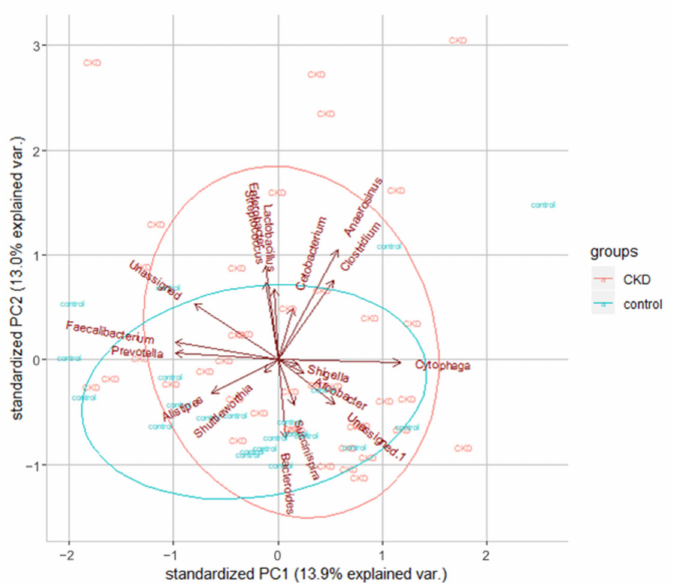
Figure 4. Dimension reduction analysis reveals the overall bacterial compositions slightly different between healthy controls and ESKD patients. The top 20 most abundant microbial genera were used in this analysis and shown with arrows in the plot. Red and green ellipses were plotted according to the 40 ESKD patients and the 22 healthy controls,